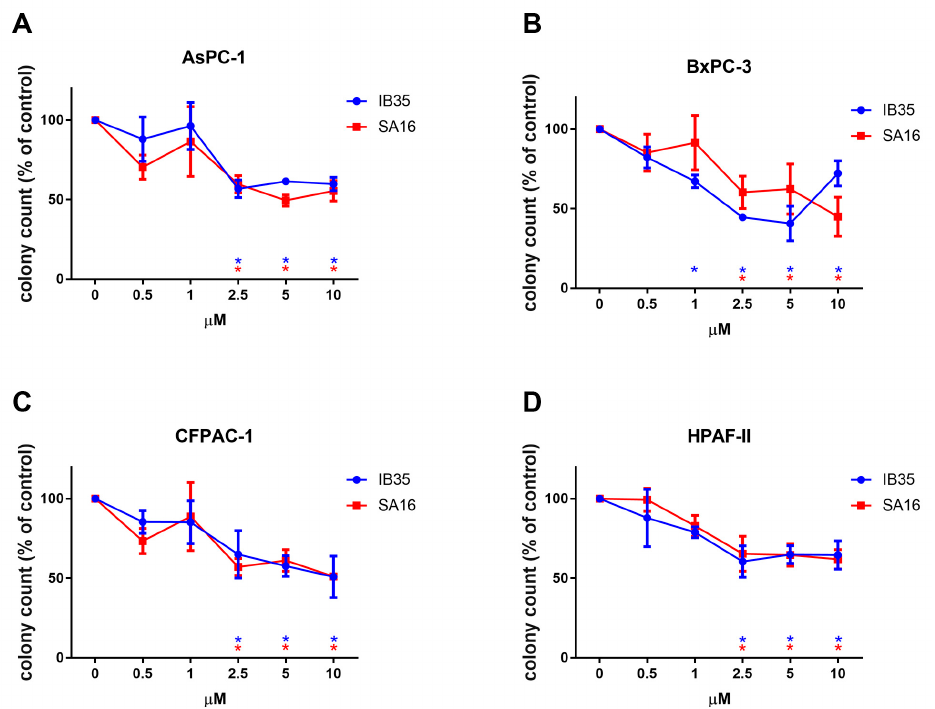
Figure 2. Dual PDK1 / Aurora A inhibitors reduce pancreatic cancer anchorage-independent colonies formation (3D assay). AsPC-1 ( A ), HPAF-II ( B ), CFPAC-1 ( C ), and BxPC-3 ( D ) cells were treated with the indicated concentrations of SA16 and IB35 and the number of colonies was assessed after 28 days. Untreated cells were incubated with the corresponding amount of vehicle (“control”). Data are expressed as percentage of control cells and are means ± SEM of at least n = 3 independent experiments performed in duplicate. * in red: SA16; * in blue: IB35.